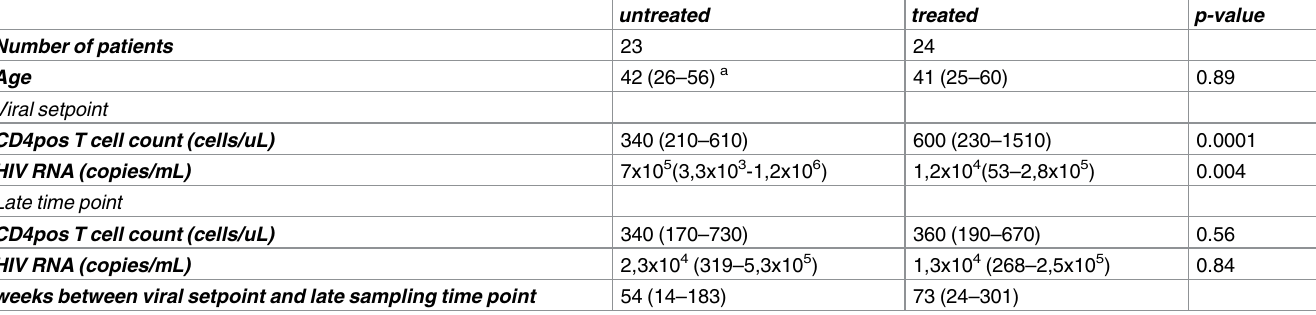
Table 1. Characteristics of study